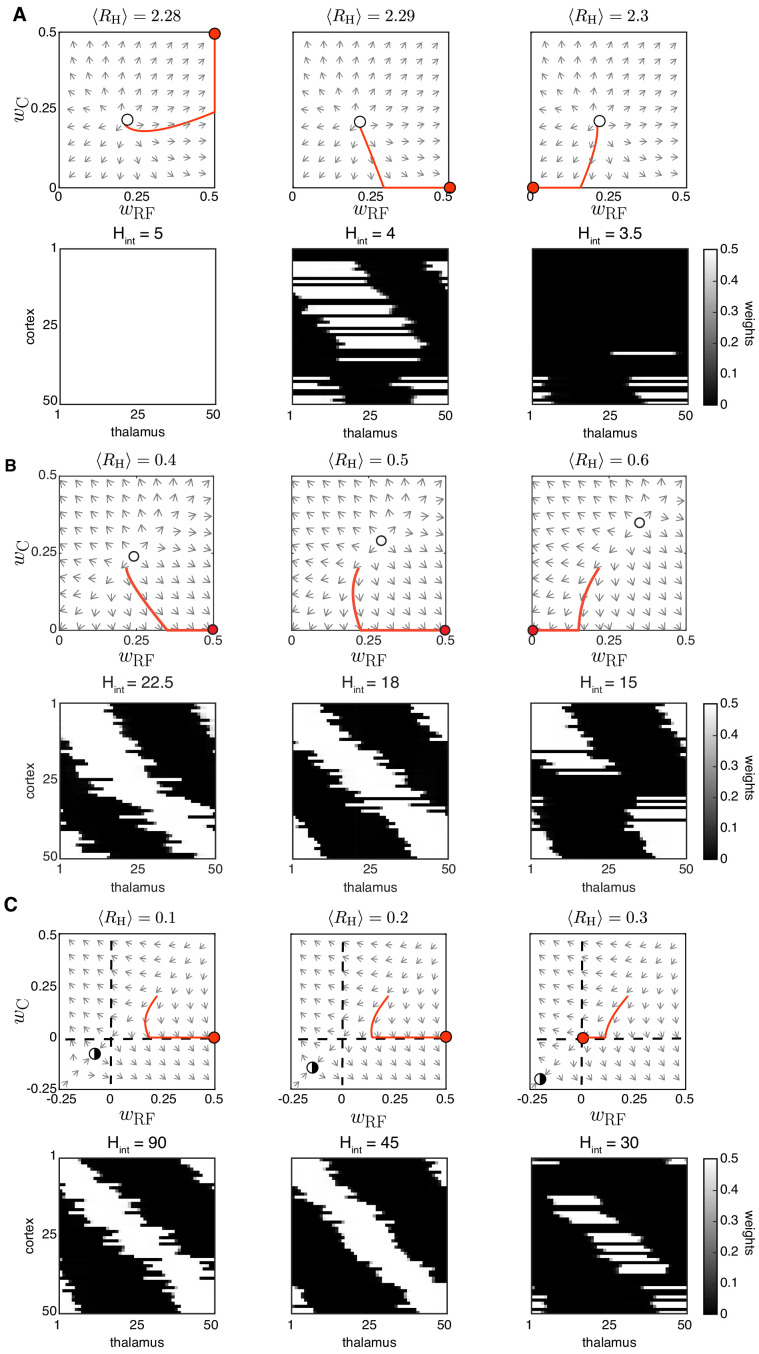
Spontaneous cortical H-events disrupt receptive field refinement.(A) Top: Phase planes of the reduced two-dimensional system for input threshold θu=0.4 (region i) and increasing strength of cortical events ⟨RH⟩ with an example trajectory (red). Selectivity can only be observed for fine-tuned ⟨RH⟩. The fixed point (open circle), an unstable node, has moved to the first quadrant. Bottom: Simulations of receptive field development with the same parameters where Hint was progressively reduced (this is the same set of parameters as shown in Figure 3A). (B) Top: Phase planes for θu=0.52 (region ii) and increasing ⟨RH⟩ with an example trajectory (red). The unstable node (open circle) moves from the origin to the first quadrant as ⟨RH⟩ increases. Bottom. Simulations with the same parameters where Hint was progressively reduced. (C) Top: Phase planes for θu=0.6 (region iii) show the transition from selective receptive fields to cortical decoupling in response to increasing ⟨RH⟩. The fixed point (half-open circle), now a saddle node because λ*<0, has moved away from the origin to the third quadrant. Bottom: Simulations with the same parameters with very infrequent H-events where Hint was progressively reduced.